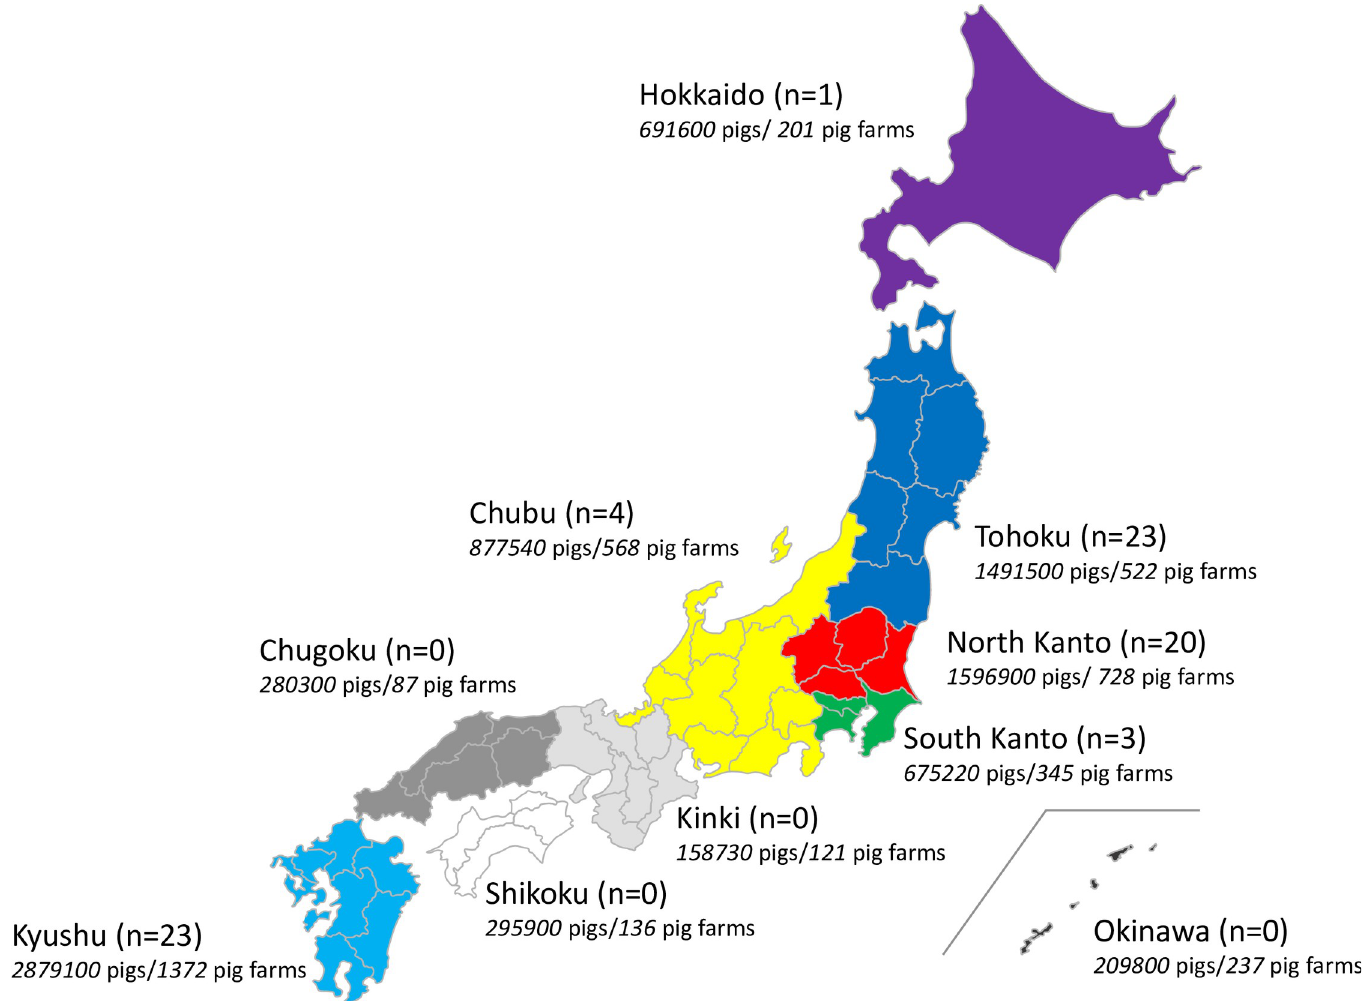
Fig 1. Locations of 74 pig farms analyzed in this study. Numbers in italics indicate the number of pigs and pig farms in the respective regions of Japan as of 1 February 2019. Blank map used for preparation of this figure was reprinted from https://www.freemap.jp/ under a CC BY license, with permission from Keisuke Inoue, original copyright 2006.